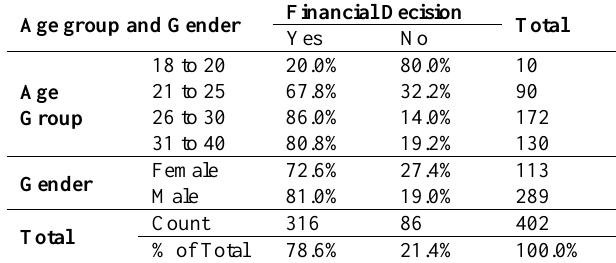
Table 2: Financial decision making